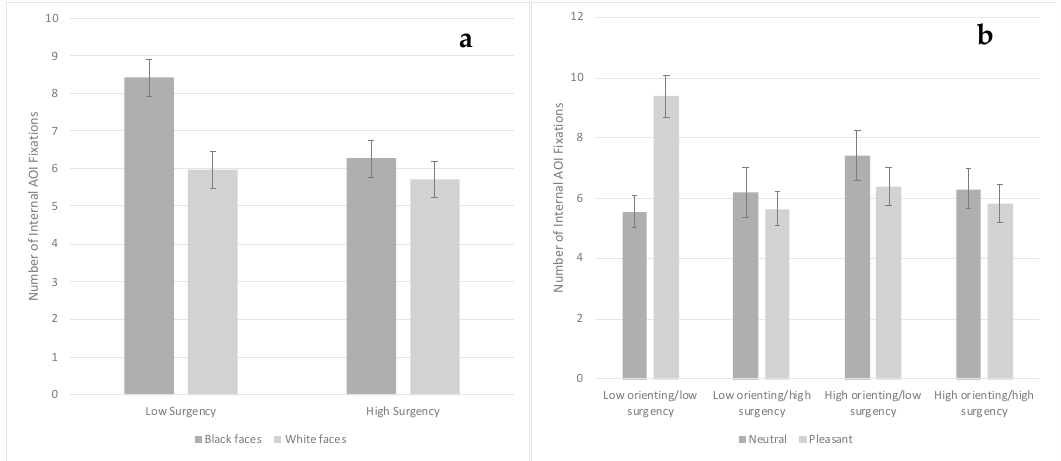
Figure 5. Number of fixations toward the internal features of the familiarized face based on face race and infants’ surgency (( a )—left chart) and based on facial expression and infants’ orienting and surgency (( b )—right chart). Bars represent standard error.